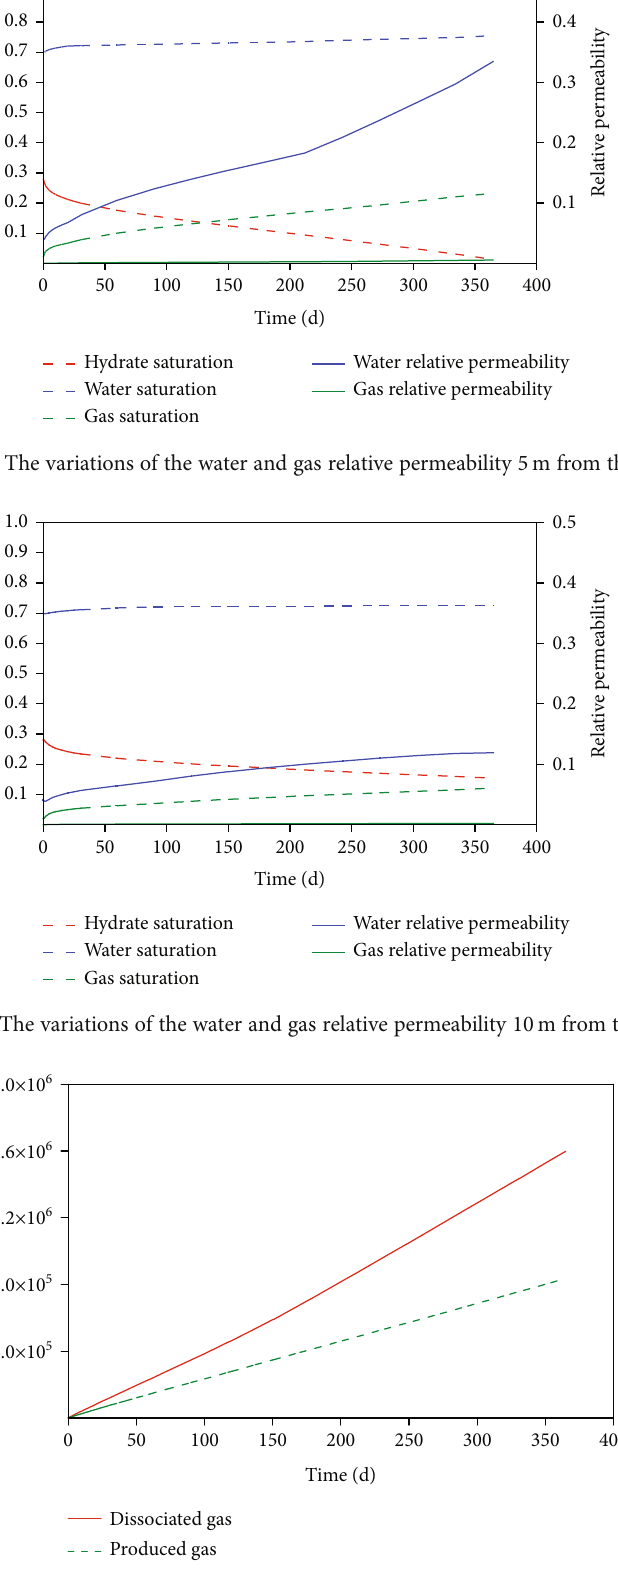
Figure 19: The comparison between the gas volume from the dissociated hydrate and the output gas volume from the